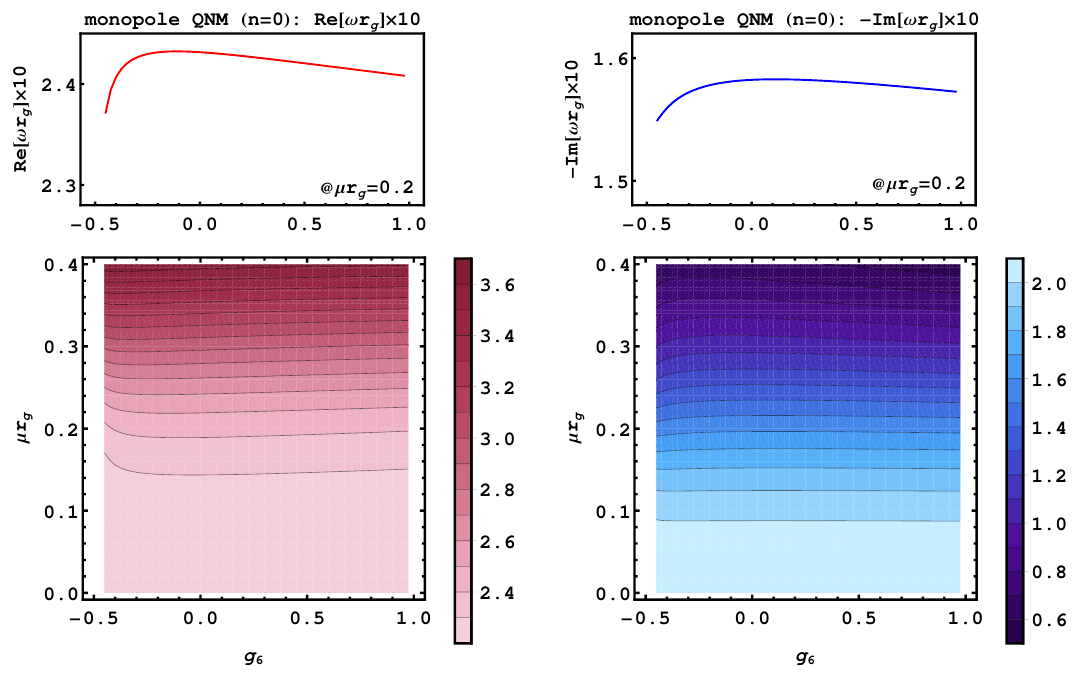
Figure 1 . Real (left-hand panels) and imaginary (right-hand panels) part of the fundamental ( n = 0 ) monopole QNM in the g 6 – µ plane (lower panels) and as a function of g 6 at µ r g = 0 . 2 . cf. figure 1, is affected by P only. The ‘ = 1 axial mode, cf. figure 2, is affected by P only. − + Finally, the two coupled polar multipole modes are affected by one pole each: the scalar mode, cf. figure 3, by P ; the vector mode, cf. figure 4, by P . While not presenting respective − + results, we expect the same pole-induced behaviour to persist for all higher ‘ > 1